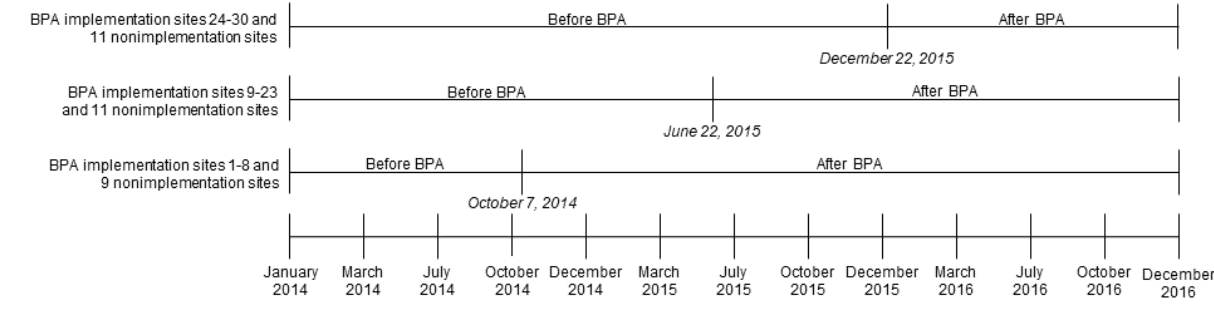
Figure 4. Before and after study periods in the difference-in-differences analysis for the 30 primary care sites that implemented the Best Practice Advisory and the 31 primary care sites that did not implement the Best Practice Advisory. BPA: Best Practice